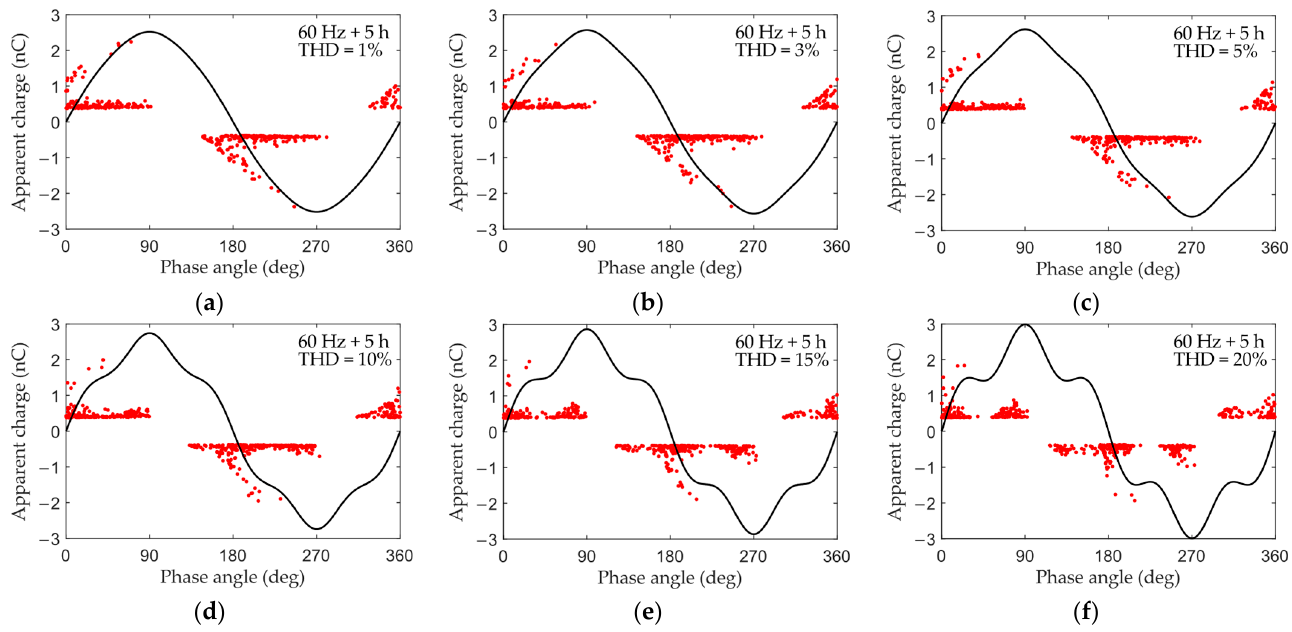
Figure 11. PRPD patterns obtained in the simulations for the cases wherein voltages distorted by the 5th harmonic component was applied with ϕ h = 0 ◦ and THD =: ( a ) 1%; ( b ) 3%; ( c ) 5%; ( d ) 10%; ( e ) 15%; ( f ) 20%.